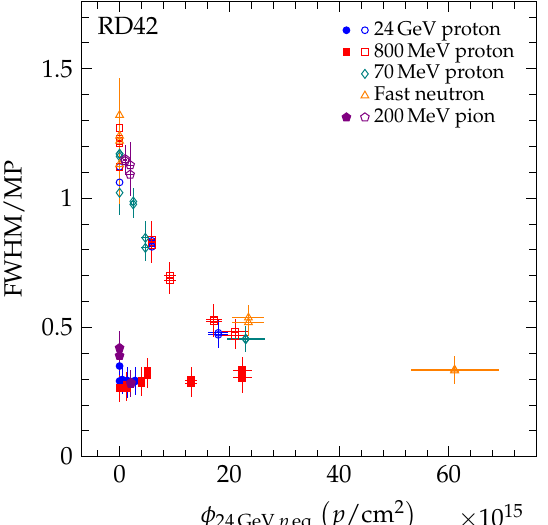
Figure 15. The FWHM/MP for scCVD (solid markers) and pCVD (open markers) diamond. The fluence of each point was scaled by the relative damage constant to the 24GeV proton equivalent